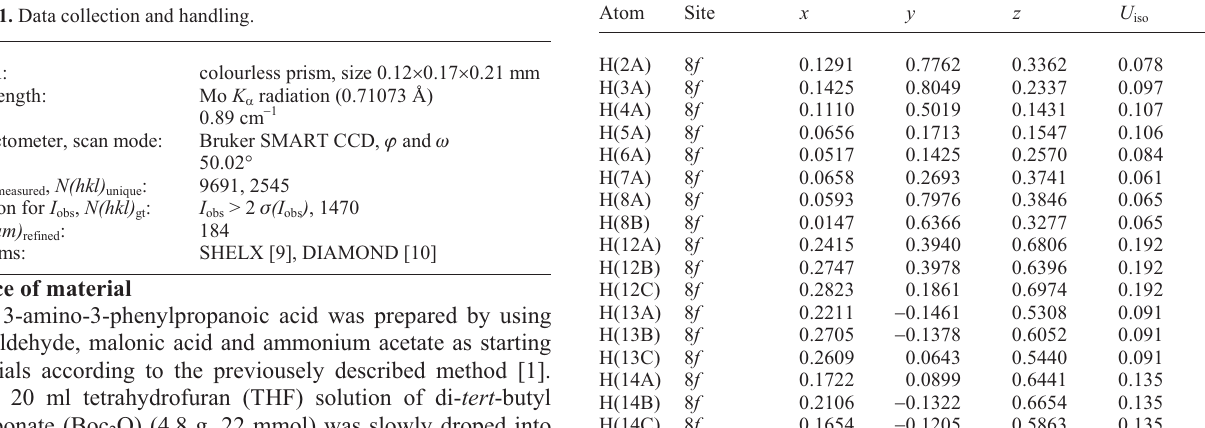
Table 1. Data collection and handling.